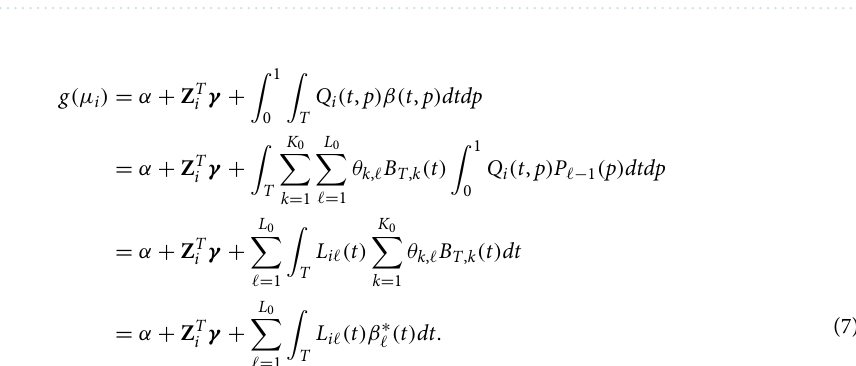
Figure 3. The first four time-varying L-moments of daily physical activity averaged within CNC (blue) and AD (red)